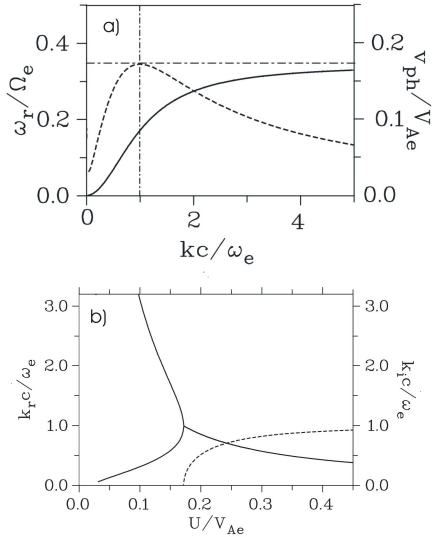
Fig. 7. (a) Dispersion relation of whistler waves at oblique prop- agation ( θ = 70 ◦ ): normalized frequency (solid line) and phase velocity (dashed line) versus wave number k (in units of the electron skin length c/ω e ). Maximum phase velocity is at kc/ω e = 1. b) Dis- persion relation of stationary whistlers: k = k(U) ; k r (solid line), k i (dashed line) are the real and imaginary parts of k , respectively, where U is the velocity of the moving frame. Exponentially grow- ing solutions ( k i 6= 0) superimposed by spatial oscillations ( k r 6= 0) exists for U/V Ae ≥ 0 . 17. That is the region where whistler oscilli- tons are